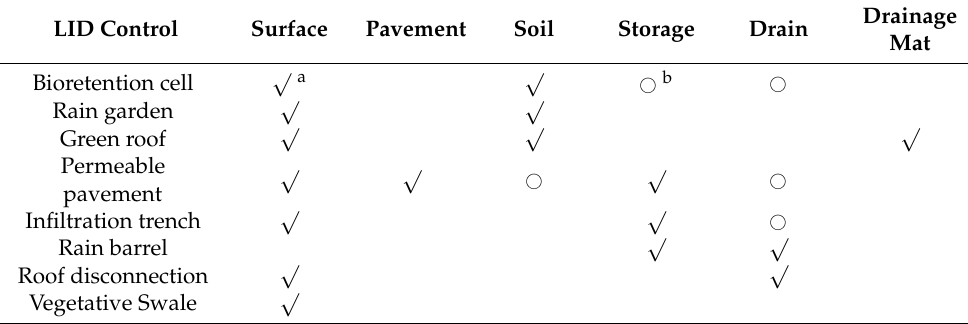
Figure 3. Conceptual diagram of LID controls simulation in SWMM. Table 1. Layers used to model different types of LID controls.